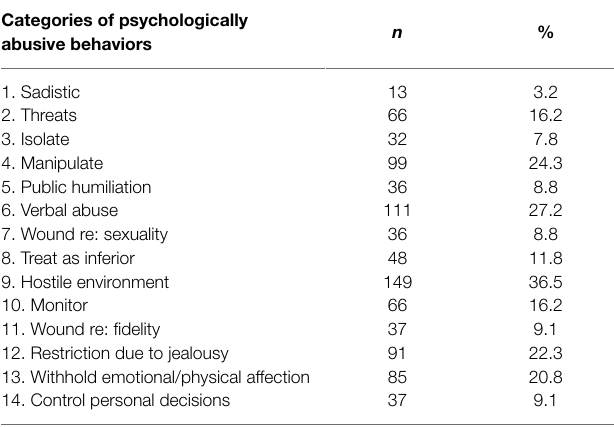
N = 408. For each category of psychological abuse, the table shows the number (n) and the proportion (%) of participants experiencing at least one behavior in the past 12